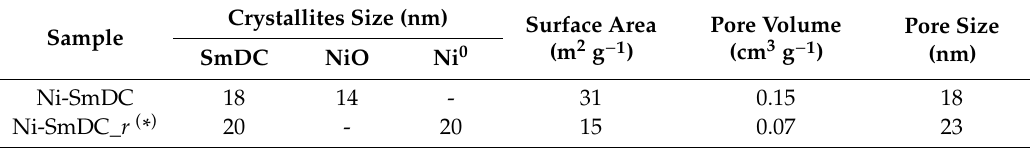
Figure 1. ( a ) XRD patterns and ( b ) N 2 adsorption/desorption isotherms and pore-width distribution of Ni-SmDC samples after calcination and after reduction treatment at 800 °C. Table 1. Textural properties of calcined and reduced Table 1. Textural properties of calcined and reduced samples.